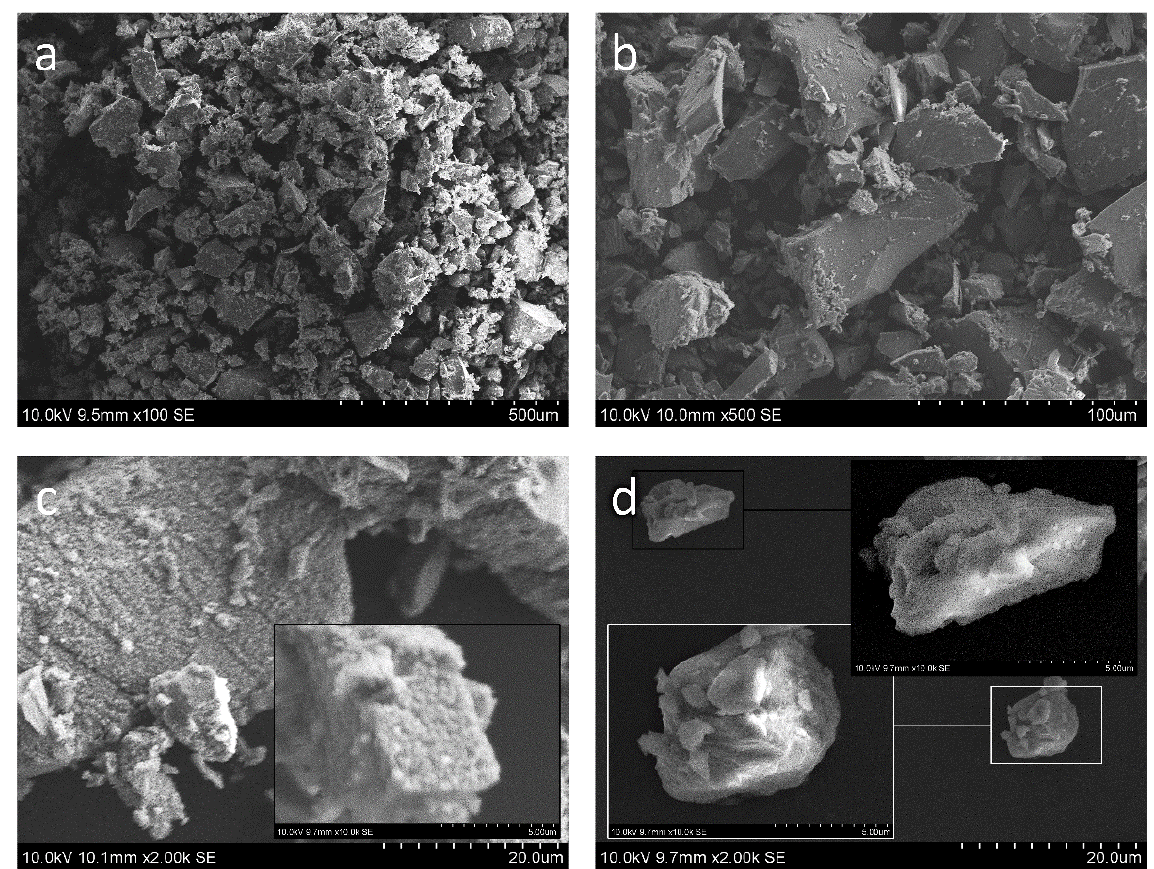
Figure 2. ( a , b ) SEM micrograph of feedstock powder morphology with a detailed view of ( c ) average as-synthesized agglomerates before DLS and ( d ) agglomerates after 30-min ultrasound treatment in DLS.